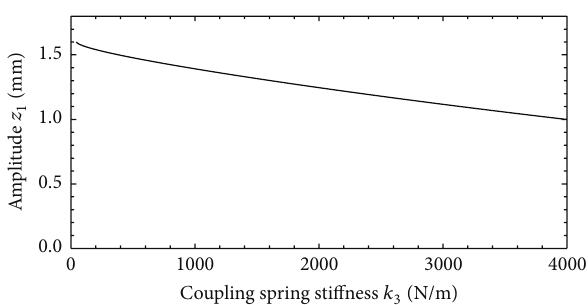
Figure 3: The amplitude of master beam and the stiffness of coupling spring as 𝐹 = 3 N and 𝜔 = 149